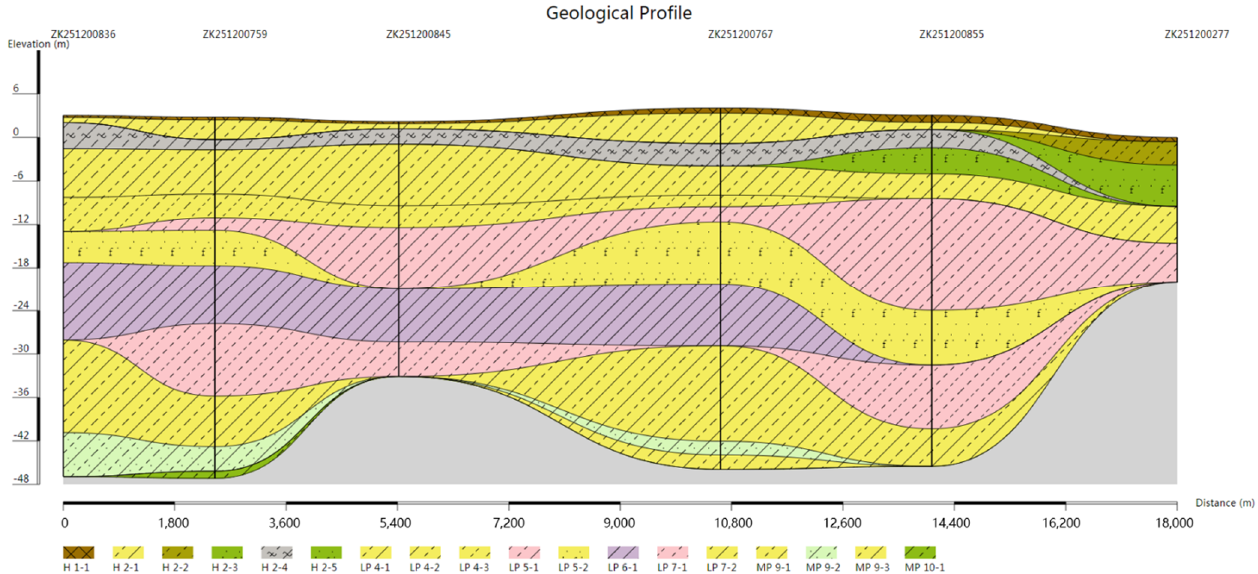
Figure 8. Geological profile II corresponding to drilling line II in Figure 7 by unique path method.